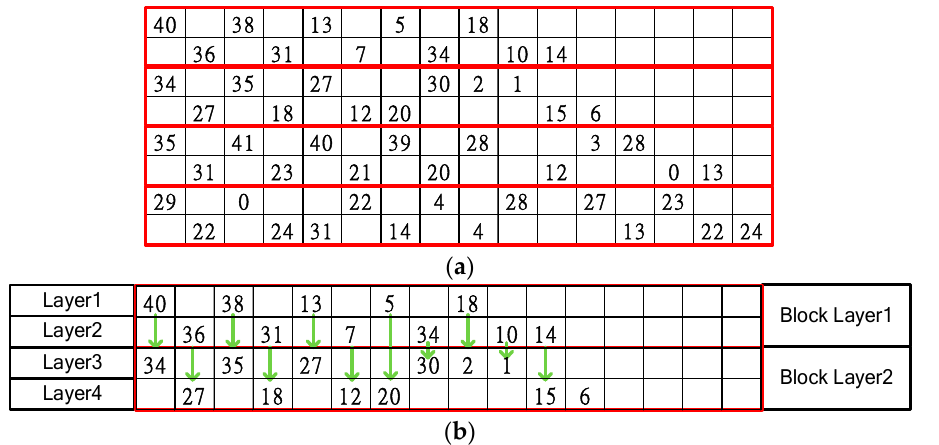
Figure 11. IEEE 802.11ad R = 1/2 block layer: ( a ) divided block layer and ( b ) block layer decoded data update transmission.